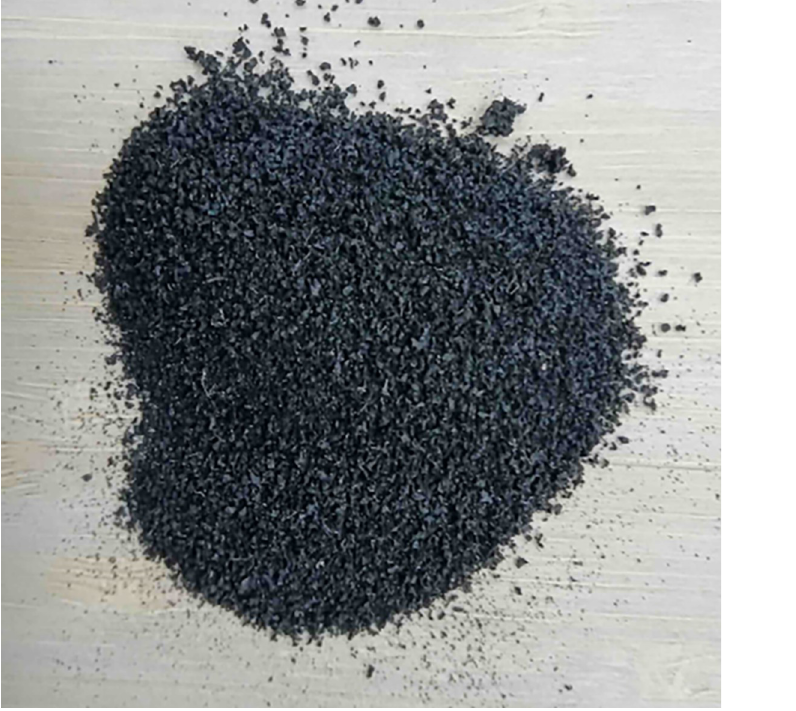
Fig 2. The surface morphology of rubber